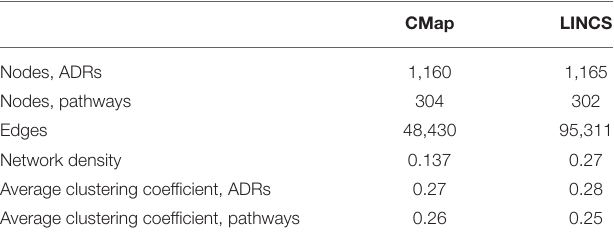
TABLE 3 | Graph parameters for pathway-adverse drug reaction (ADR)